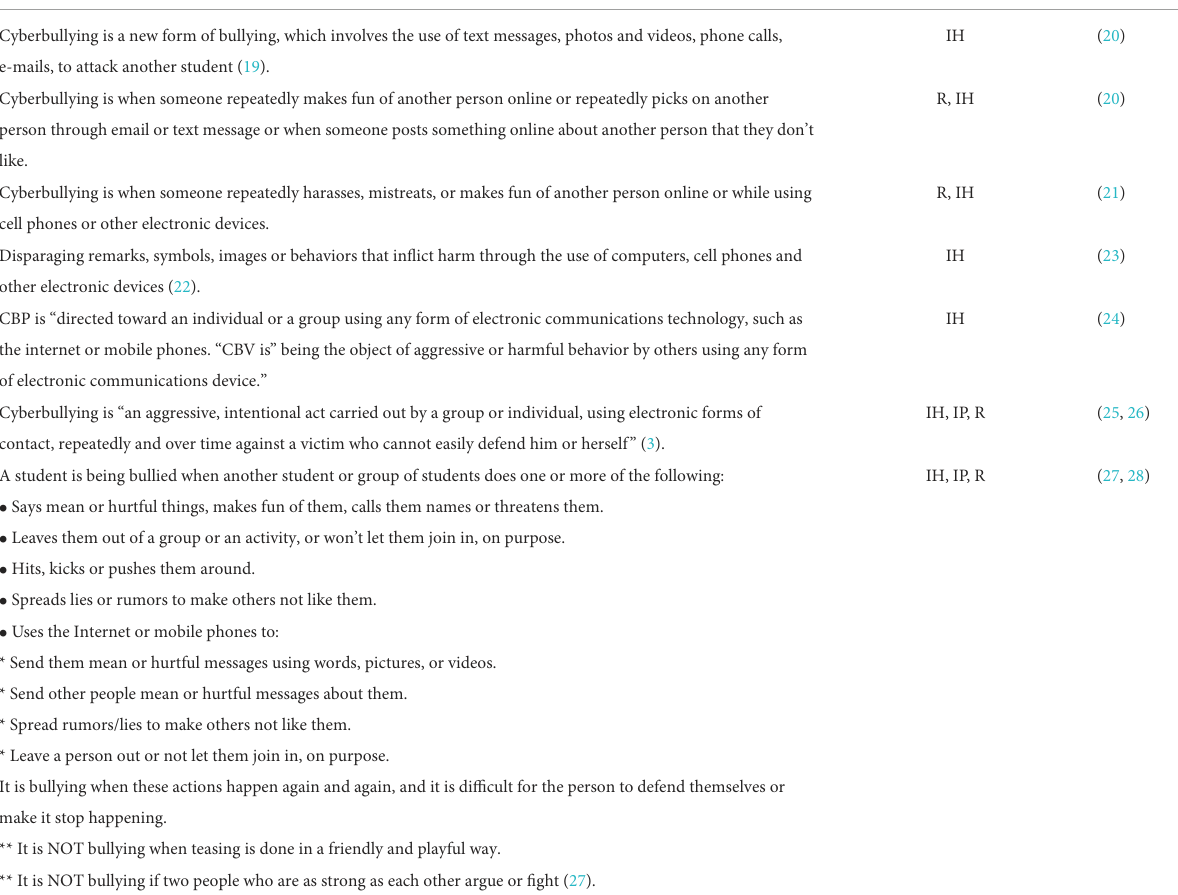
TABLE 3 Definitions provided in the reviewed